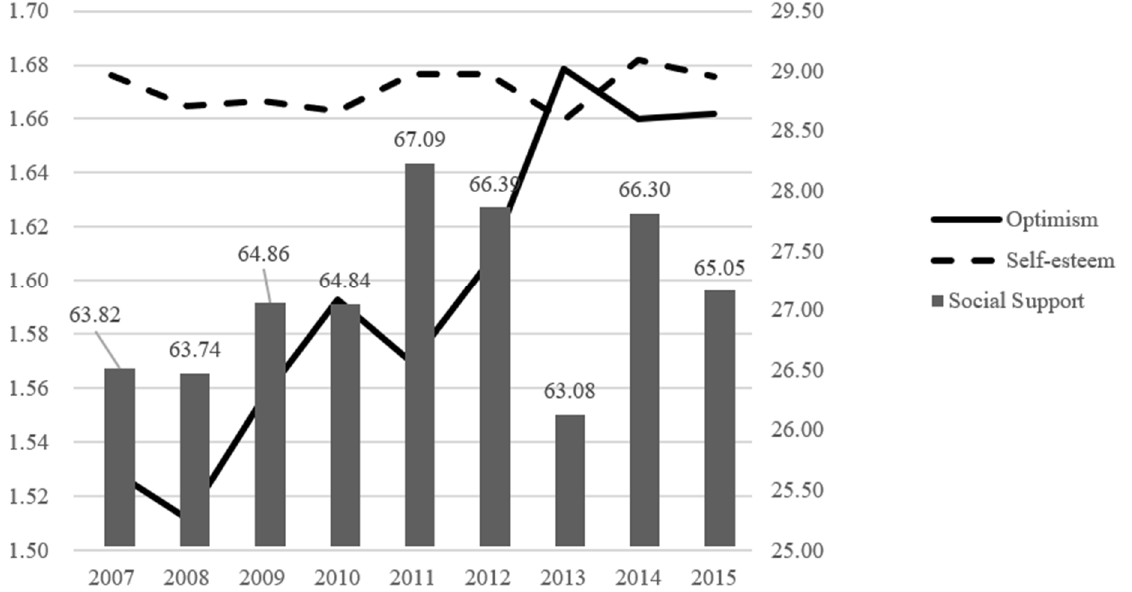
Figure 2. Trends in optimism, self-esteem, and perceived social support from 2007 to 2015. Table 4. Optimism and self-esteem in college students from 2007 to 2015.